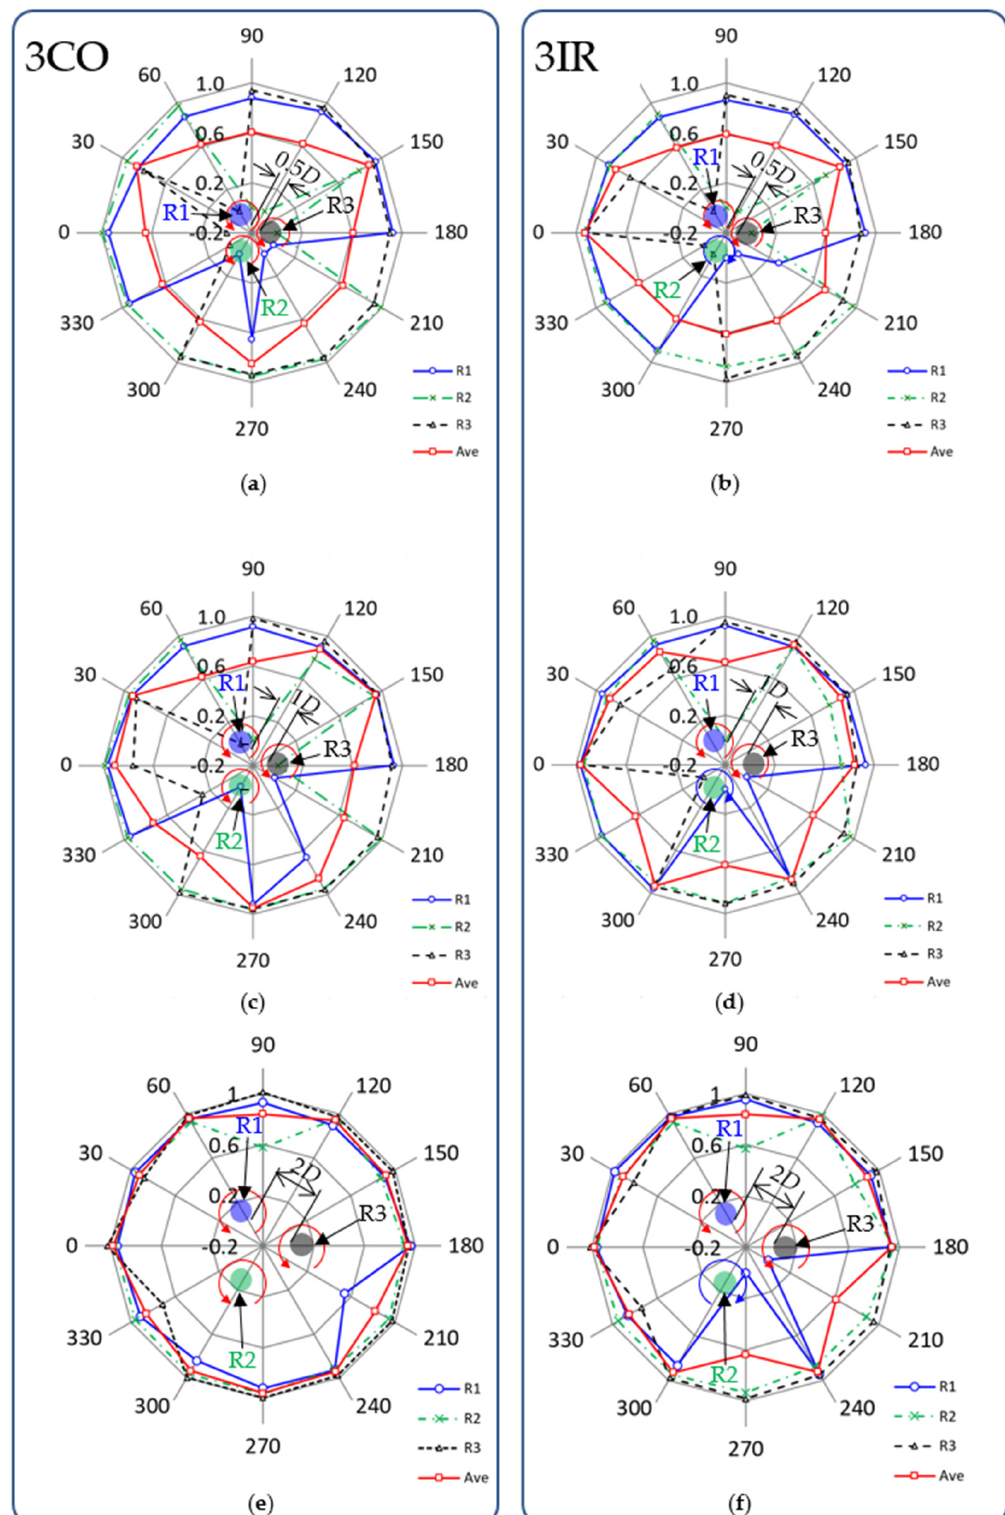
Figure 17. Configurations of 12-wind-direction dependence of normalized rotational speed in a trio of VAWT models at V = 12 m/s: ( a ) 3CO configuration, g / D = 0.5; ( b ) 3IR configuration, g / D = 0.5; ( c ) 3CO configuration, g / D = 1; ( d ) 3IR configuration, g / D = 1; ( e ) 3CO configuration, g / D = 2; ( f ) 3IR configuration, g / D = 2.